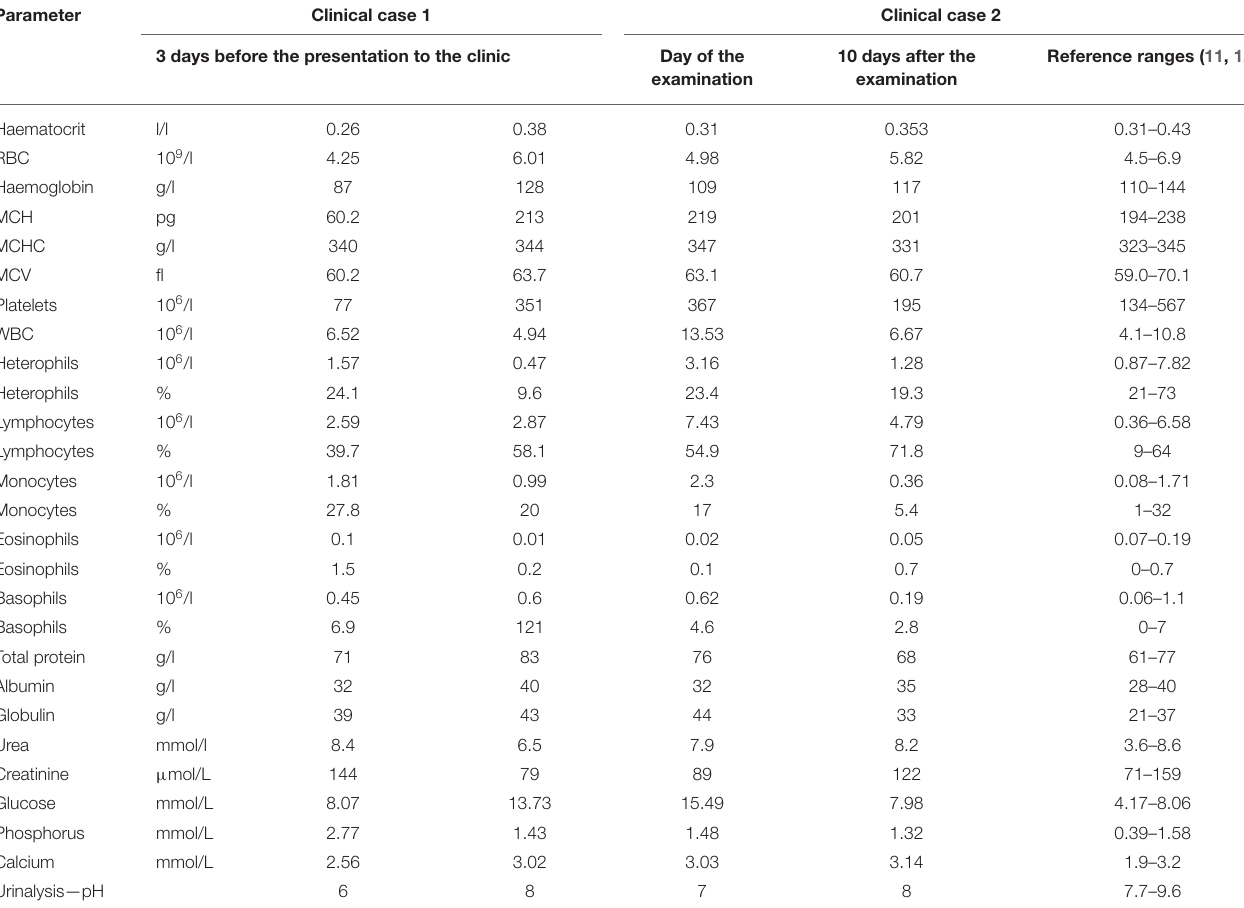
TABLE 1 | Haematology, selected plasma chemistry parameters, and urine pH of a rabbit with appendicitis.